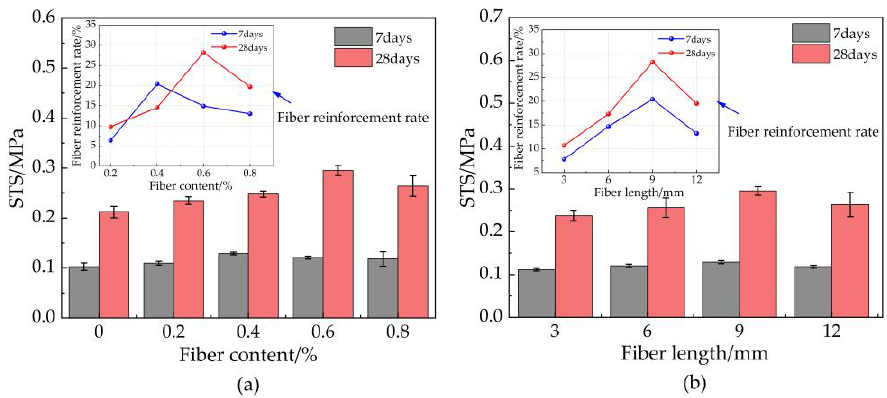
Figure 9. Effect of basalt fiber on STS of BFBCP: ( a ) fiber content; ( b ) fiber